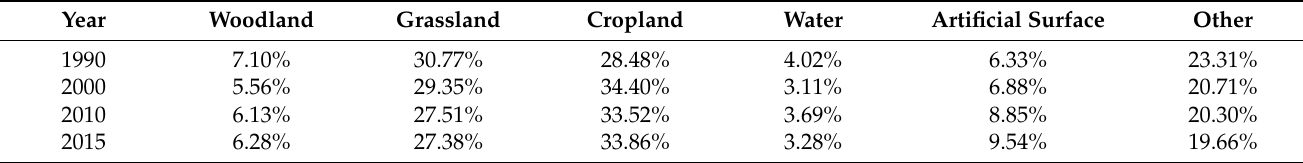
Table 1. Changes in the subsurface of the Yellow-intake Irrigation Area.